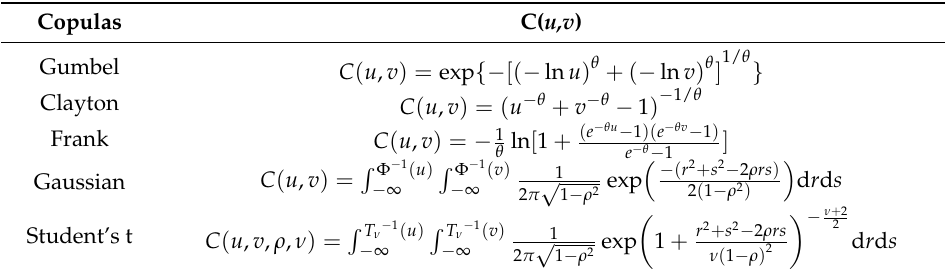
Table A1. Common bivariate copula